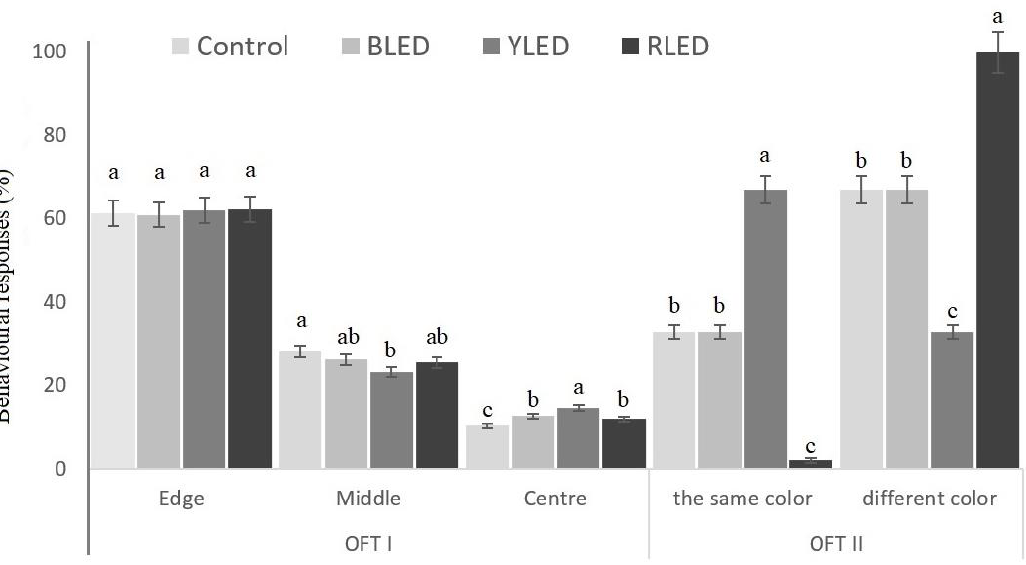
Figure 7. Behavioural responses of the birds to an object that they were thought to have never seen (unfamiliar object) in OFT I (positions of the birds on the platform %). The results of the OFT II test observation rate of preferring their own or a different coloured compartment (%). Means with different lowercase superscripts are significantly different at p <